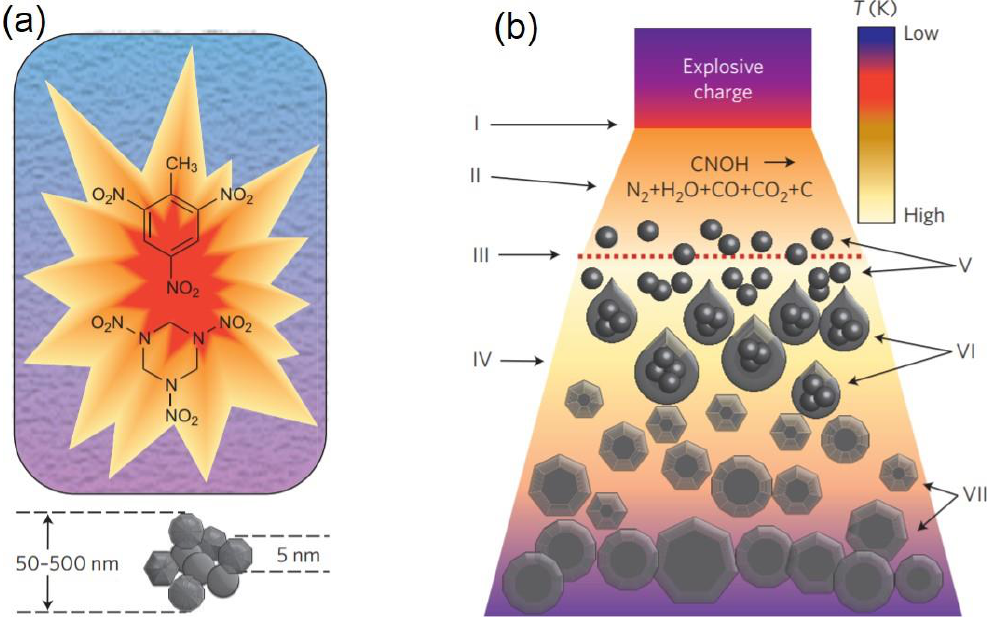
Figure 2. ( a ) Detonation process. A mixture of 60% TNT (C 6 H 2 (NO 2 )CH 3 ) and 40% hexogen (C 3 H 6 N 6 O 6 ) is detonated inside a metallic chamber filled either with water (liquid or ice) or gas (an atmosphere of N 2 , Ar, or CO 2 ). Then, 4–5 nm sized nanodiamonds (NDs) agglomerated into sub-micrometer clusters are obtained. ( b ) Schematics of NDs synthesis upon shock wave propagation. The detonation (I) leads to chemical dissociation of the carbon precursor (II), which can be the explosive molecules or graphite. The dashed line (III) represents the region where the pressure required to form the diamond phase is reached. The detonation products expand (IV), and the carbon atoms condense and crystallize (V) to form nanoclusters (VI). Finally, NDs crystallize, starting from carbon nanoclusters, grow, and agglomerate (VII). Reproduced with permission from [1], Springer, 2012.